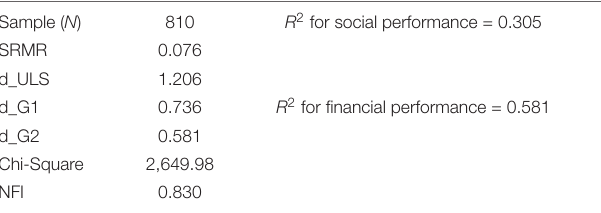
TABLE 6 | Model fit summary.